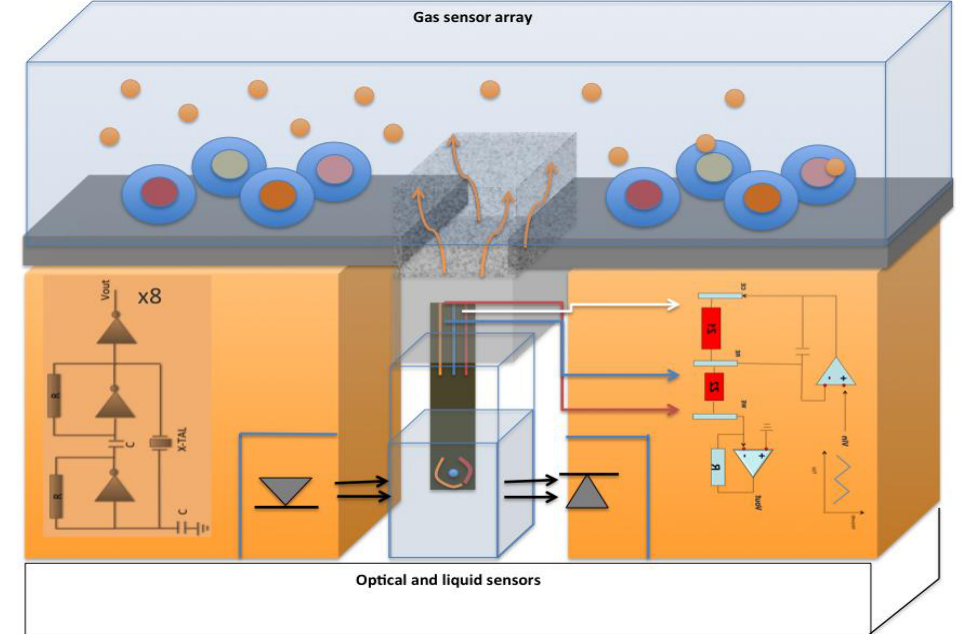
Figure 6. Concept design of a system composed of three parts: optical transduction, liquid sensors and gas sensors array. The sample under test could be contemporaneously analyzed by the three